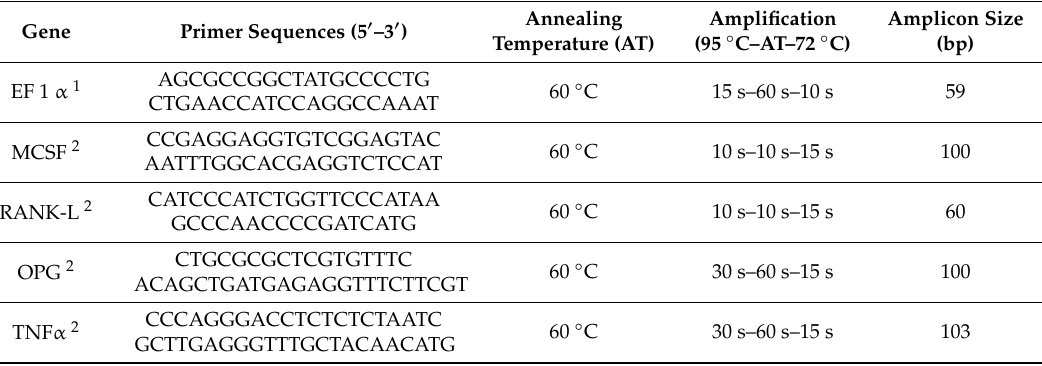
Table 1. Primers for quantitative real-time